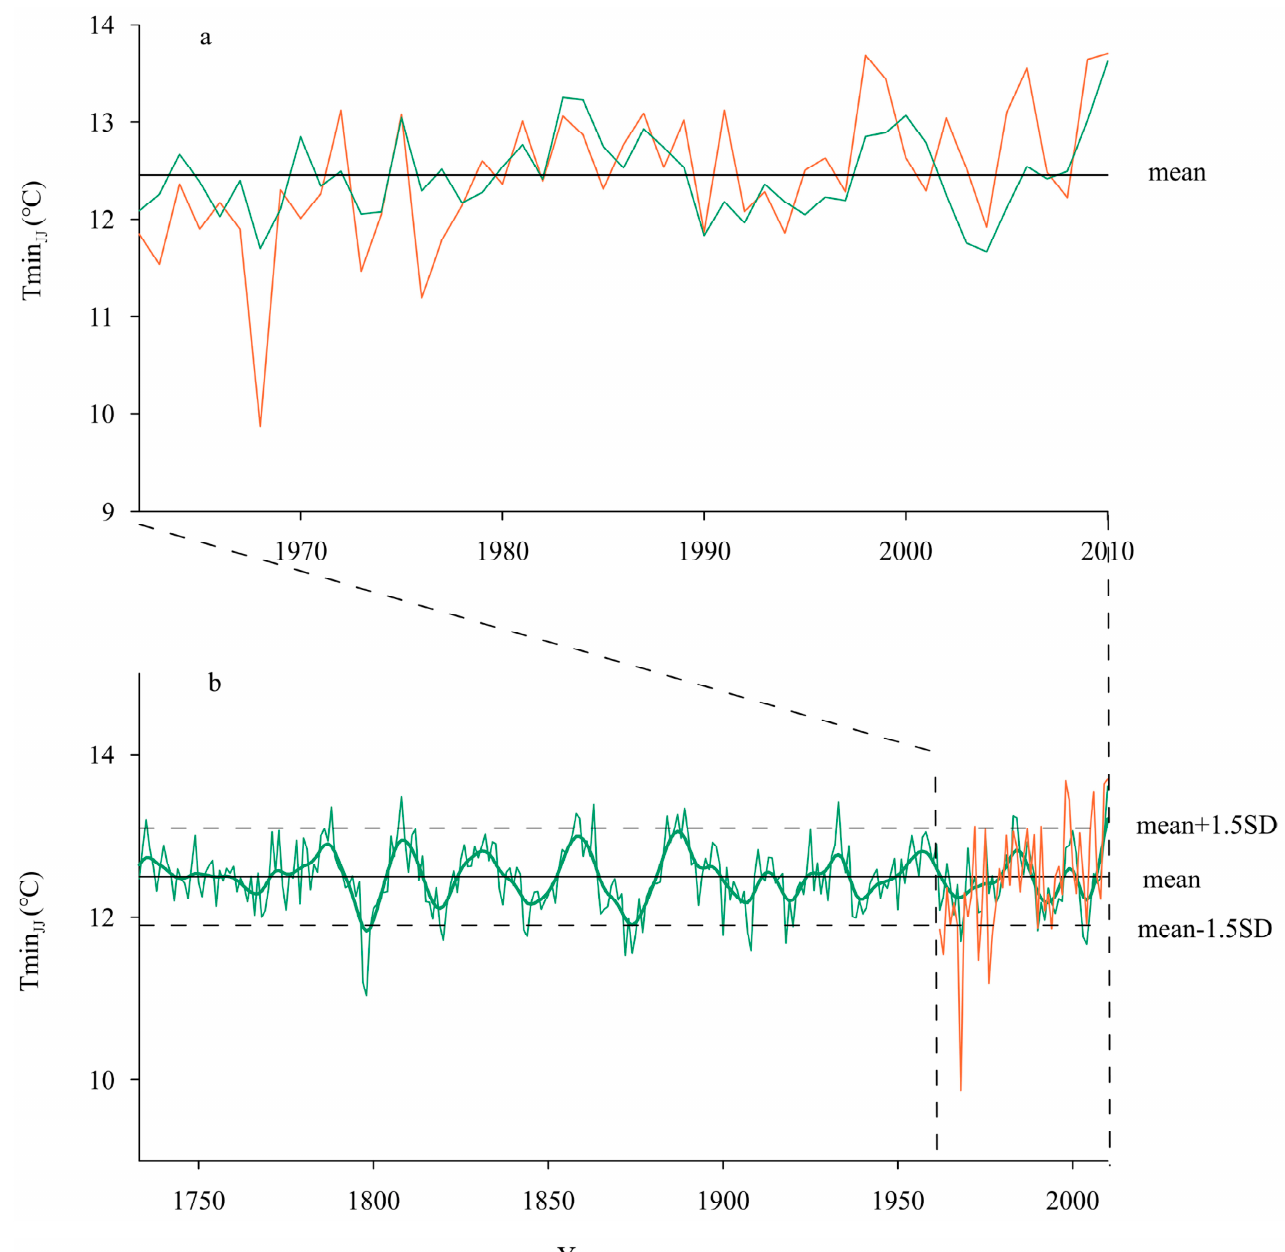
Figure 5 . Comparisons between the reconstructed and observed July–June average minimum temperature (Tmin JJ ) during the period of 1962~2010 ( a ) and the reconstructed Tmin JJ in the reliable period of 1733~2010 ( b ). The thin orange and green lines represent the observed and reconstructed Tmin JJ , respectively. The thick green line indicates 11-year low-pass fi ltering of the reconstruction.